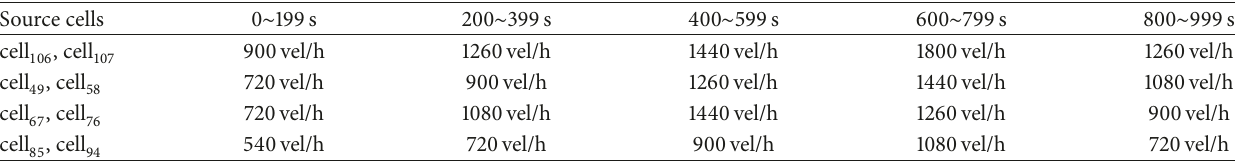
Table 2: Setting of traffic input value.